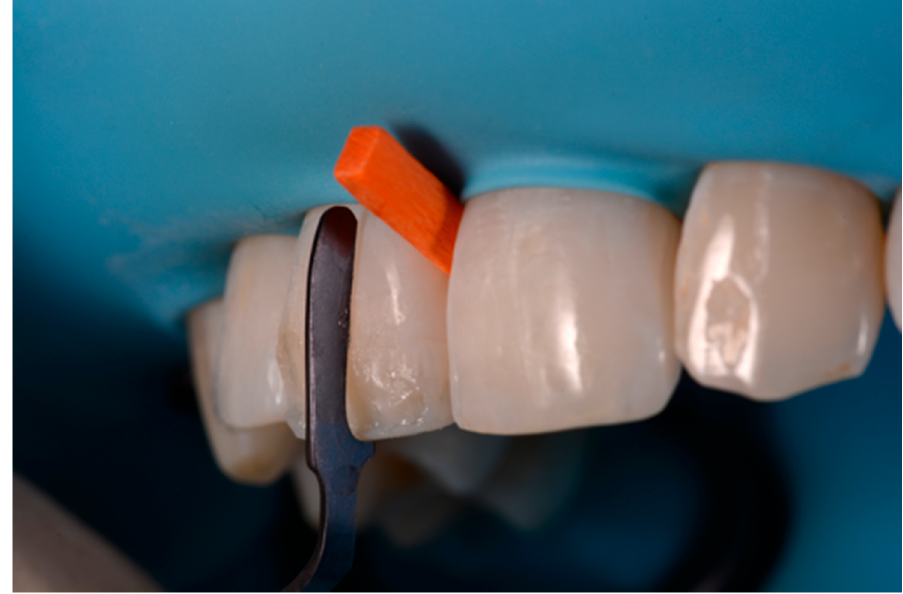
Figure 55. Checking and modeling external translucent shade with specific caliper.